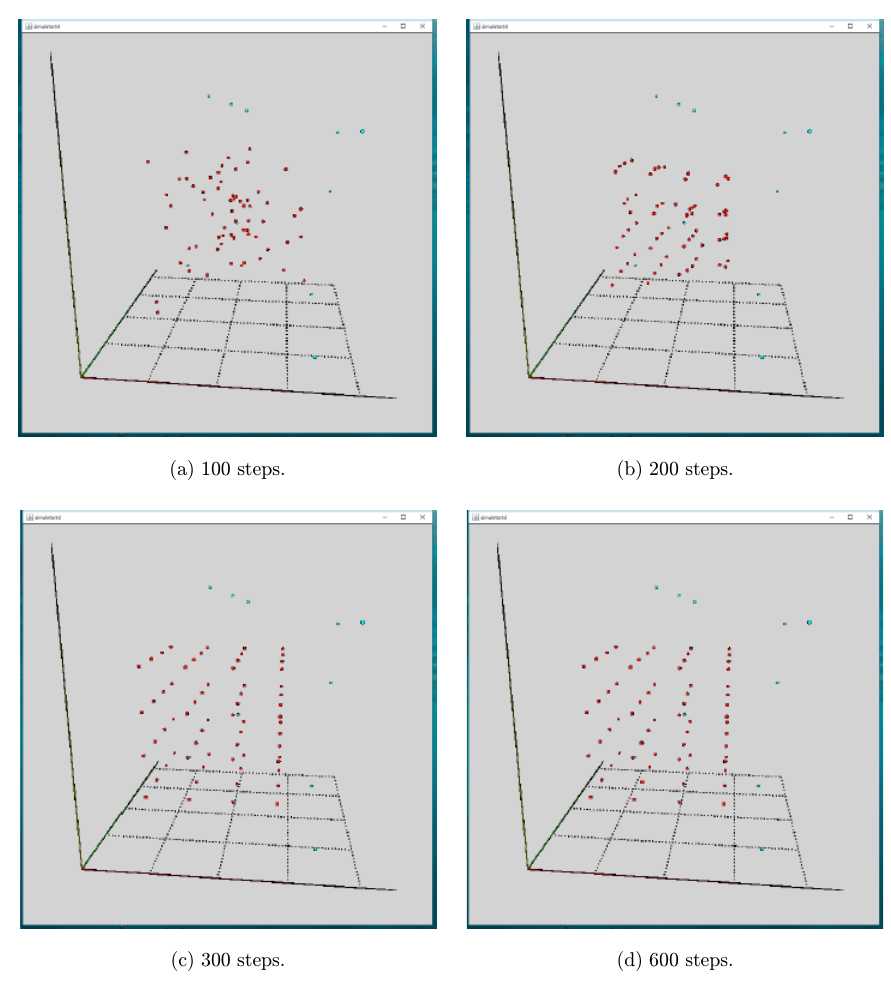
Fig. 19. Illustration of the emergence of a cubic formation. Panels (a) – (d) show the states after 100 steps, 200 steps, 300 steps and 600 steps,